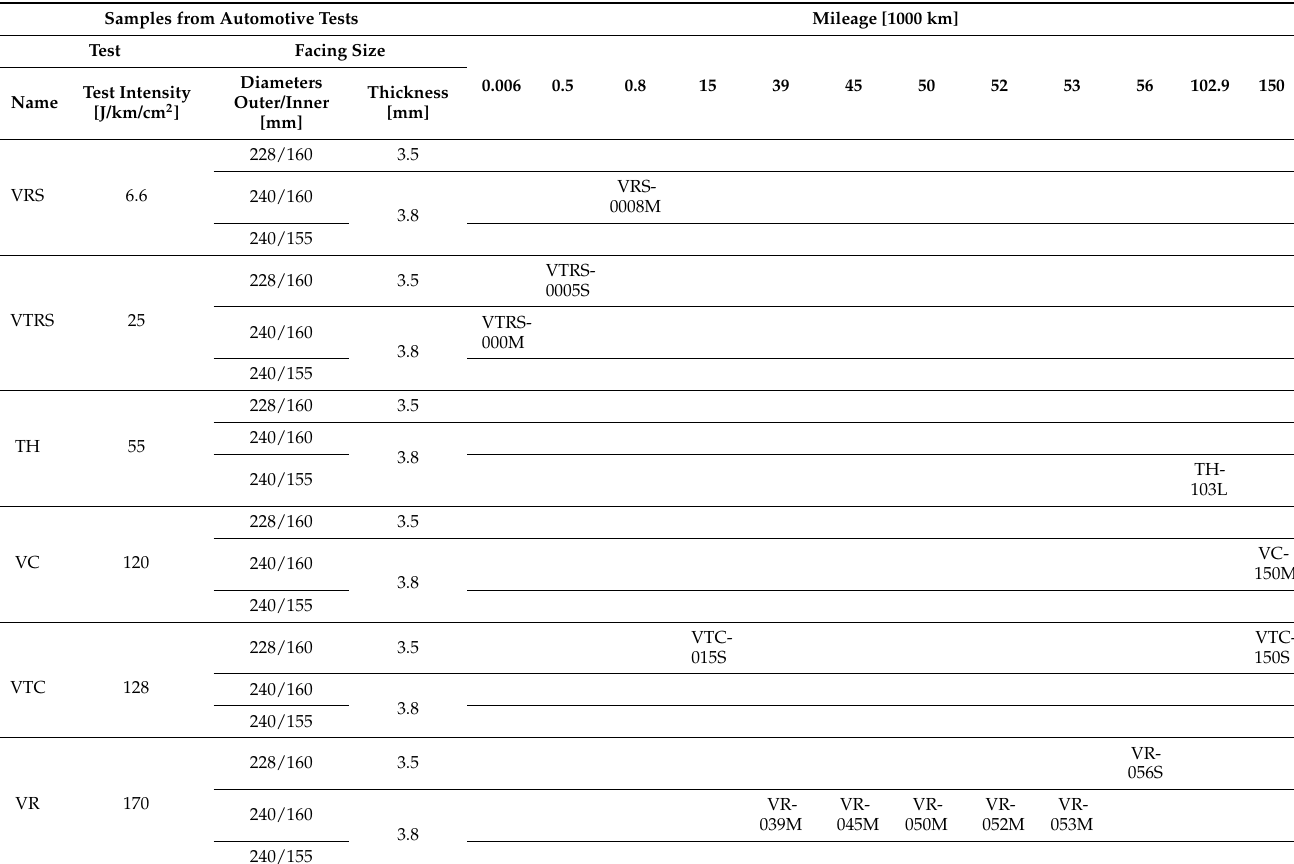
Table 5. Matrix of automotive tests: test samples along mileage and test intensity axes. Samples from Automotive